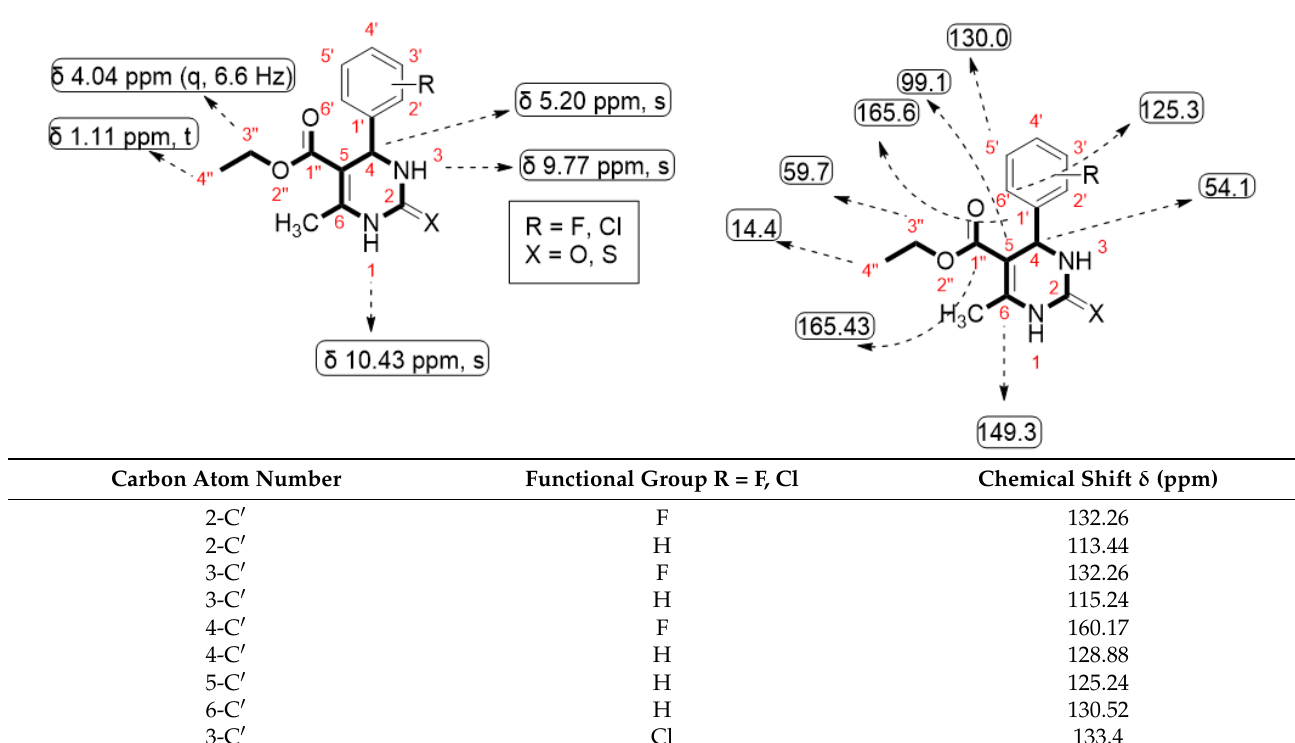
Table 1. 13 C-NMR (DMSO, 25 MHz) δ values.